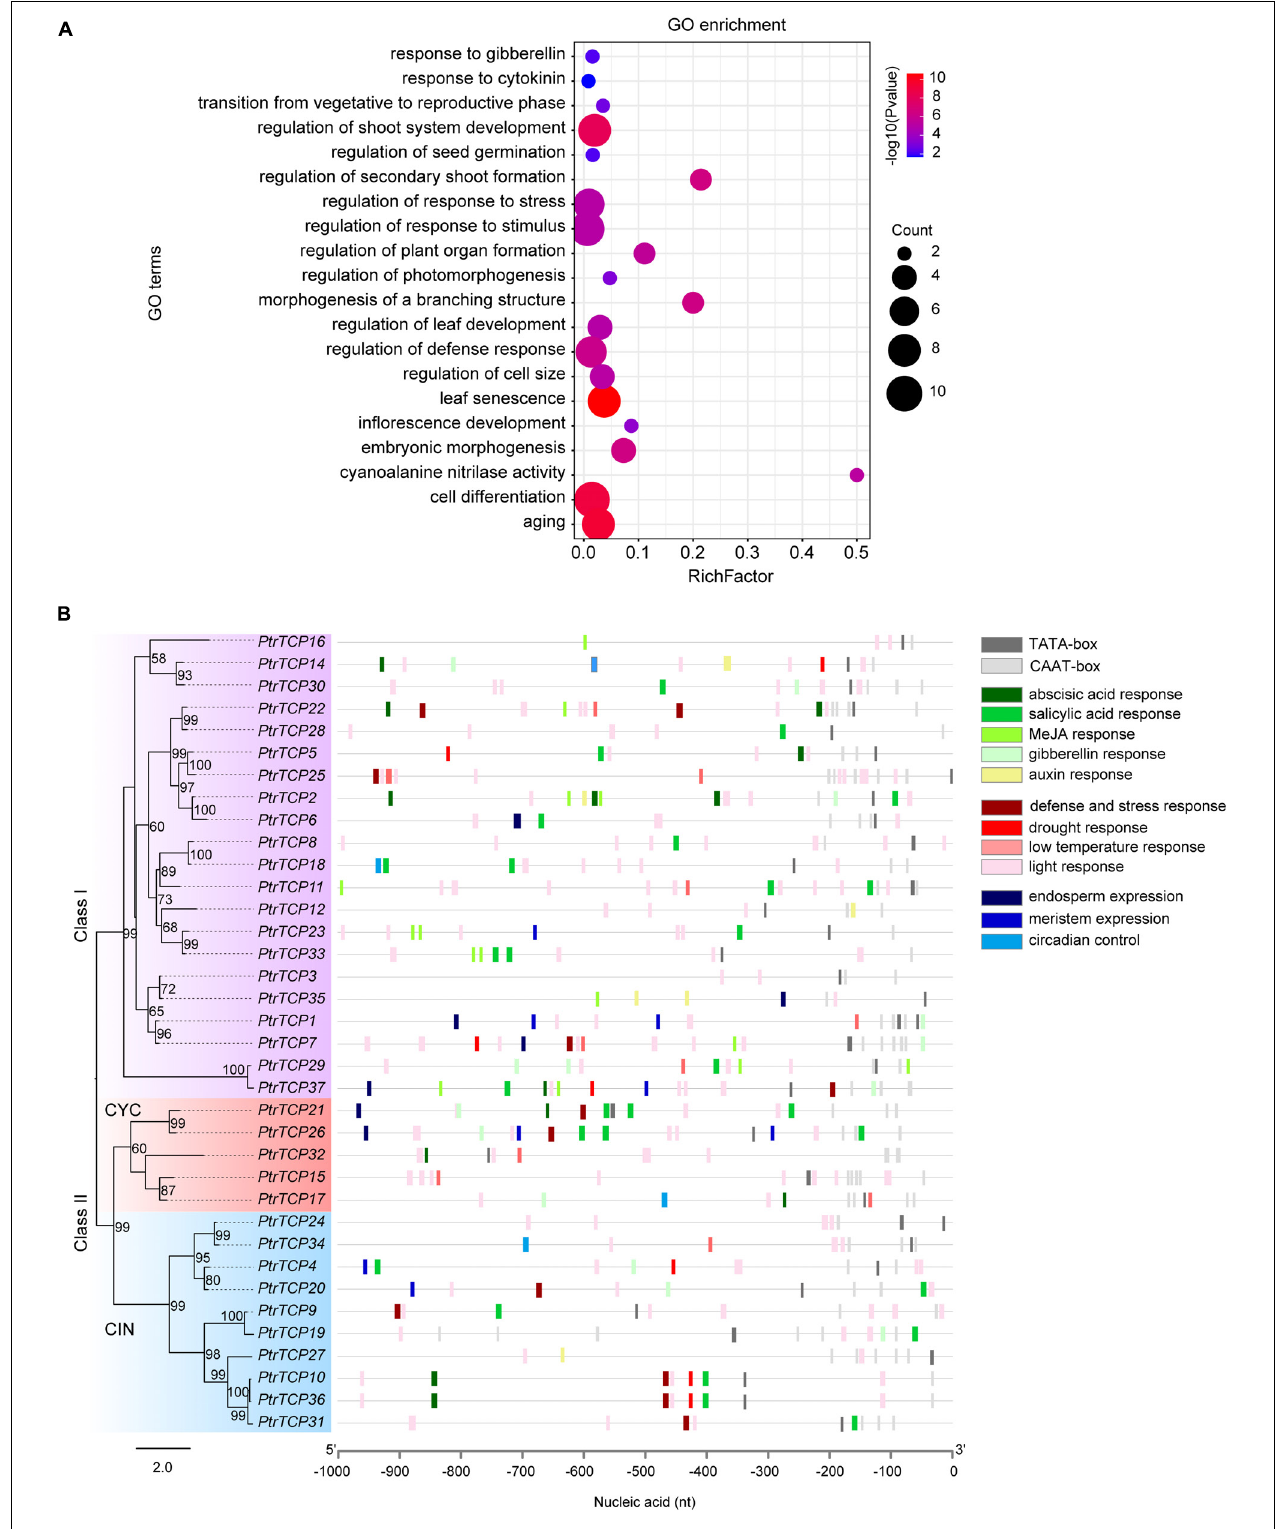
FIGURE 3 | GO enrichment and cis -regulatory element analysis of PtrTCP family genes. (A) Gene ontology (GO) enrichment analysis of PtrTCP family genes. The dot size represents the number of enriched genes, and the colored bar represents the significant enrichment level of GO term. (B) Distribution of the cis -regulatory elements in the 1-kb promoter sequence upstream of the translation initiation site (TIS) of PtrTCP genes.